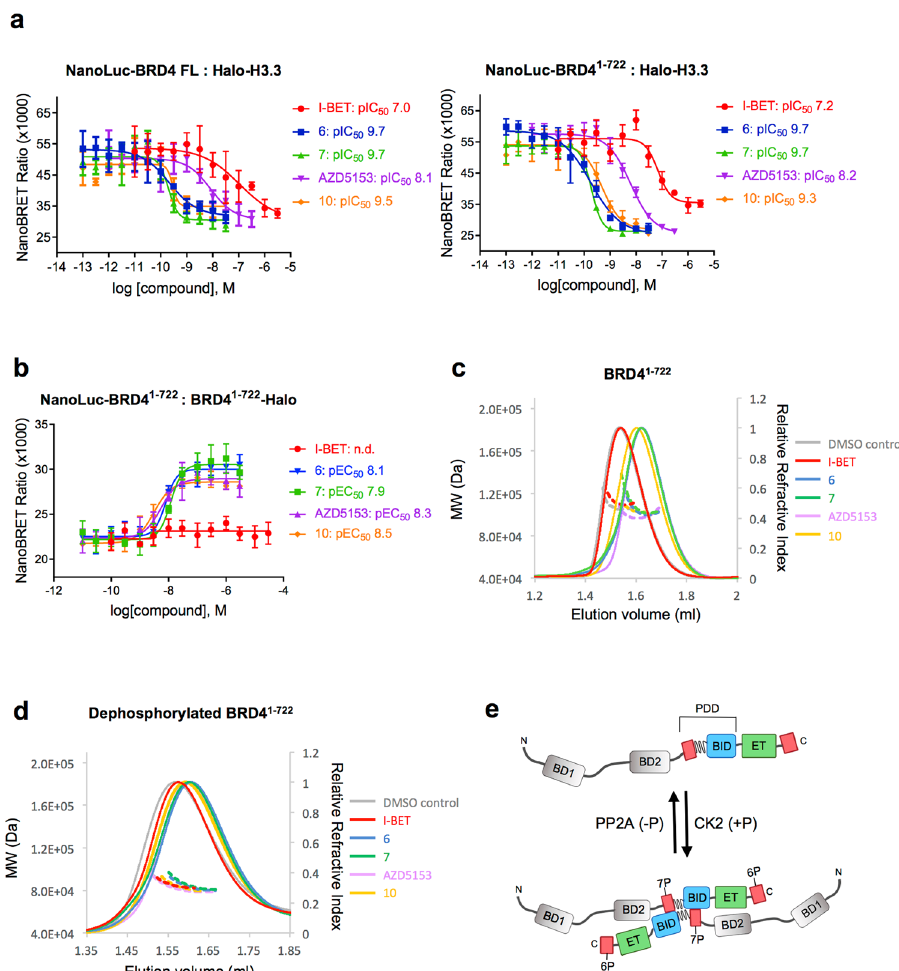
Fig. 6 biBET inhibitors induce BRD4 compaction in vitro and in cells. a Effects of increasing concentration of bivalent compounds versus monovalent I-BET on the interaction between H3 and BRD4 full length or H3 and BRD4 1 – 722 measured by NanoBRET. The mean with SD is reported ( n = 4 independent experiments). b Effects of increasing concentrations of bivalent compounds versus monovalent I-BET on BRD4 1 – 722 dimerization. The mean with SD is